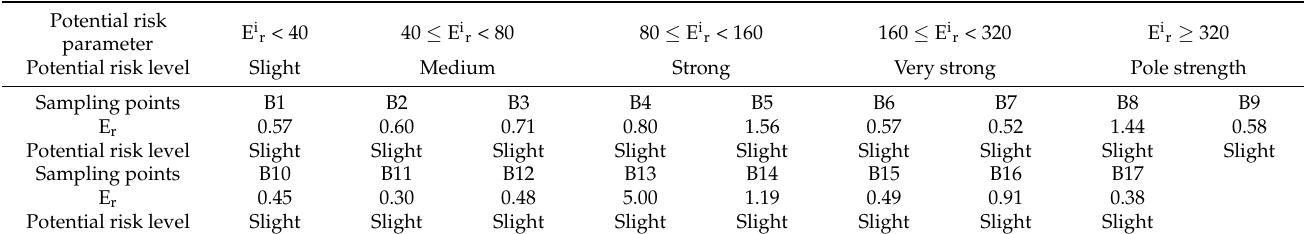
Table 2. Results of pollution assessment for PCBs in the sediments of the Beiluo River using the potential ecological risk